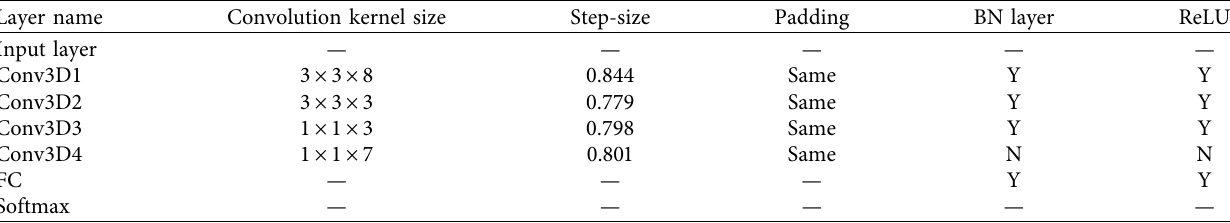
Figure 3: Schematic diagram of M-3DCNN network classification method. Table 1: M-3DCNN network parameters.